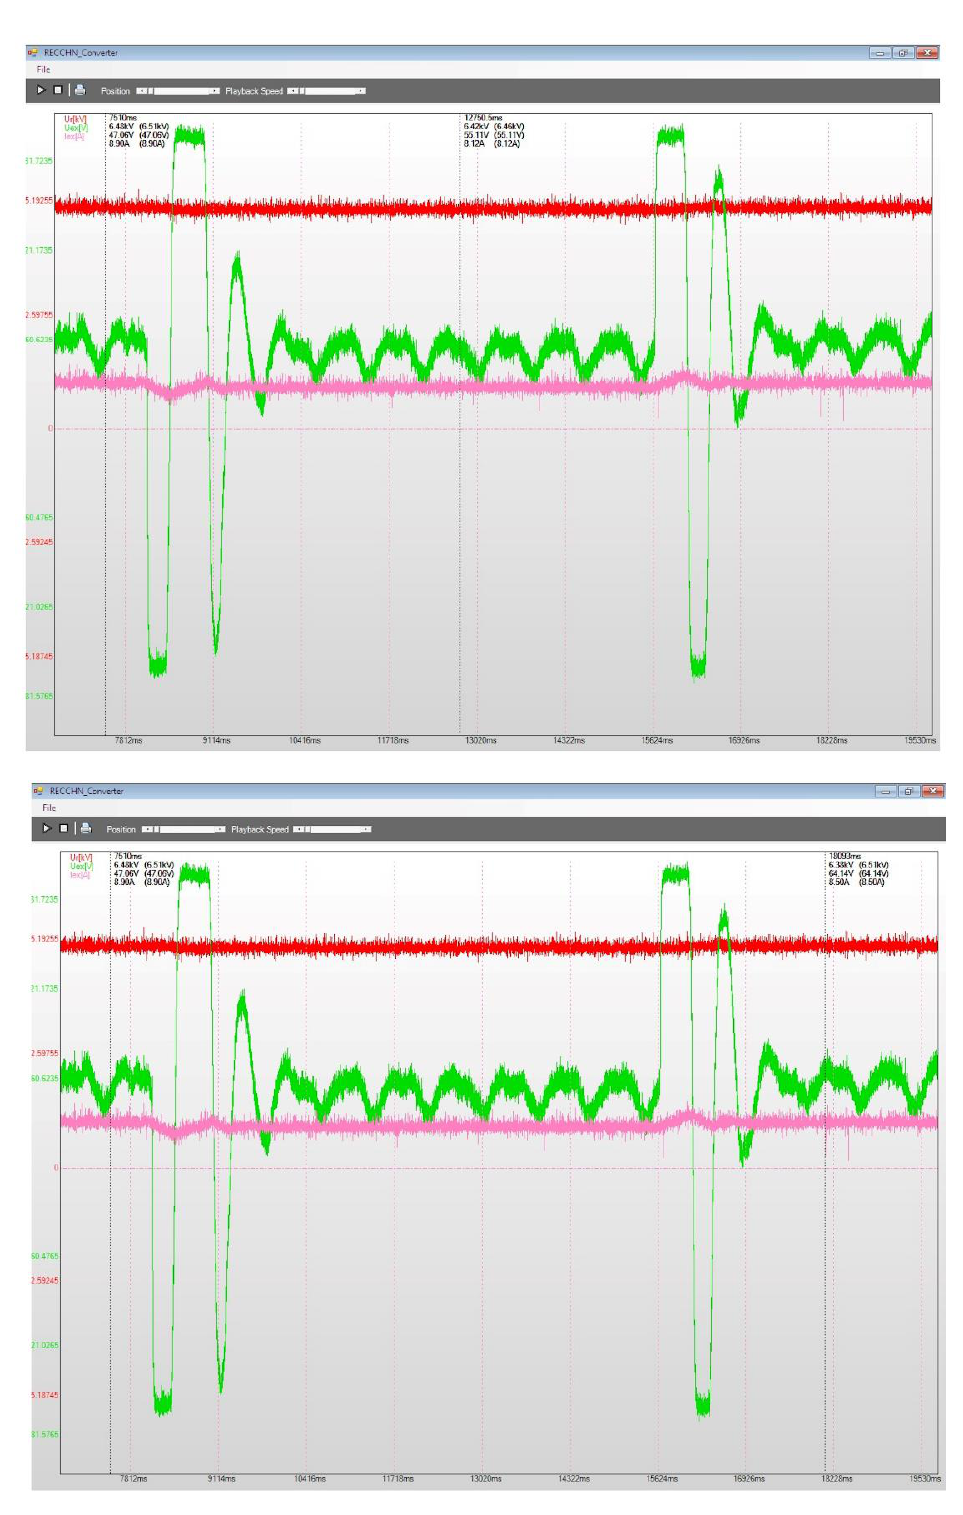
Figure 16. 5% step power decrease (top diagram) and increase (bottom diagram), CHE Gura Lotrului, V â